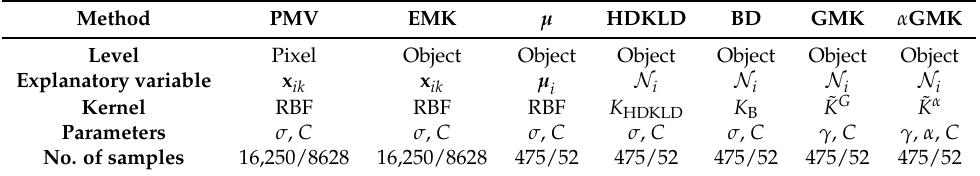
Table 3. Characteristics of the methods used in this